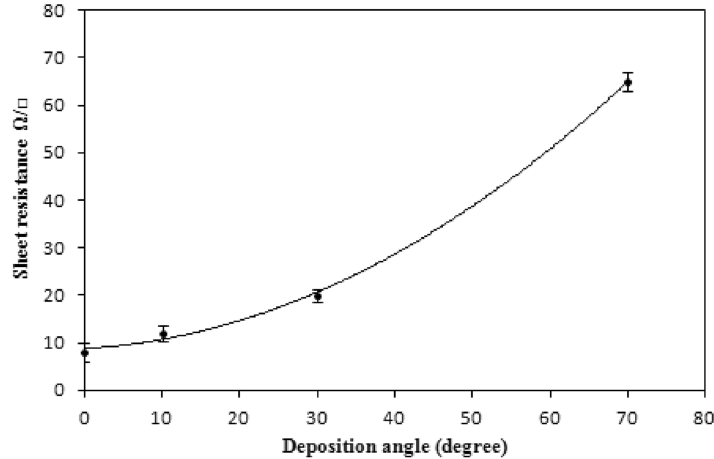
Figure 4. Dependence of film sheet resistance on the deposition angle.